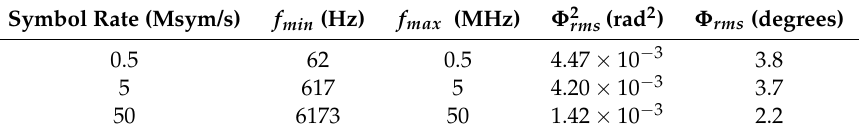
Table 5. Phase Errors versus the Symbol Rate.